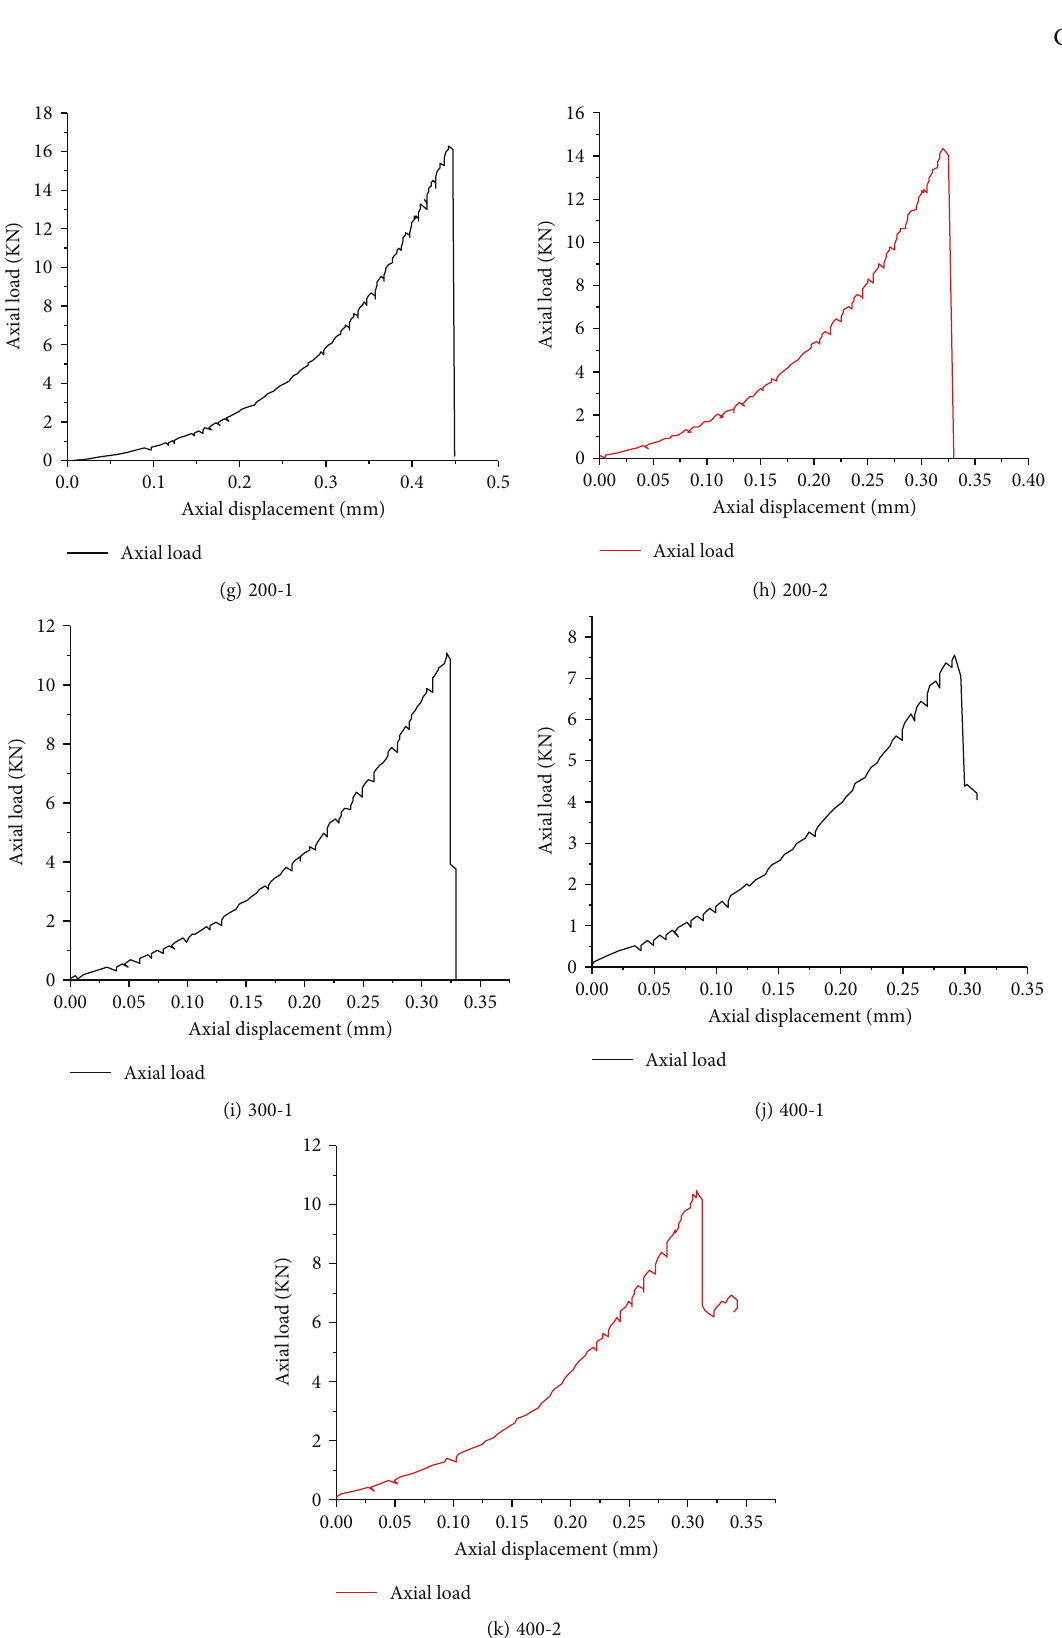
Figure 3: The load displacement curve of rock under di ff erent treatment methods in Brazil splitting